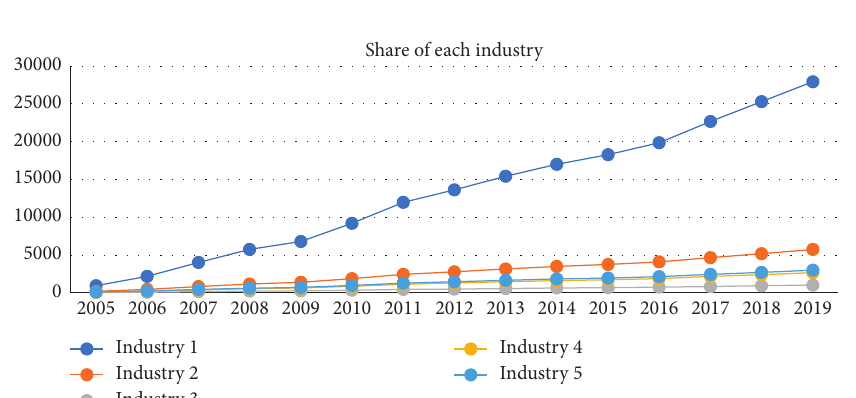
Figure 5: T&U trend of real estate.